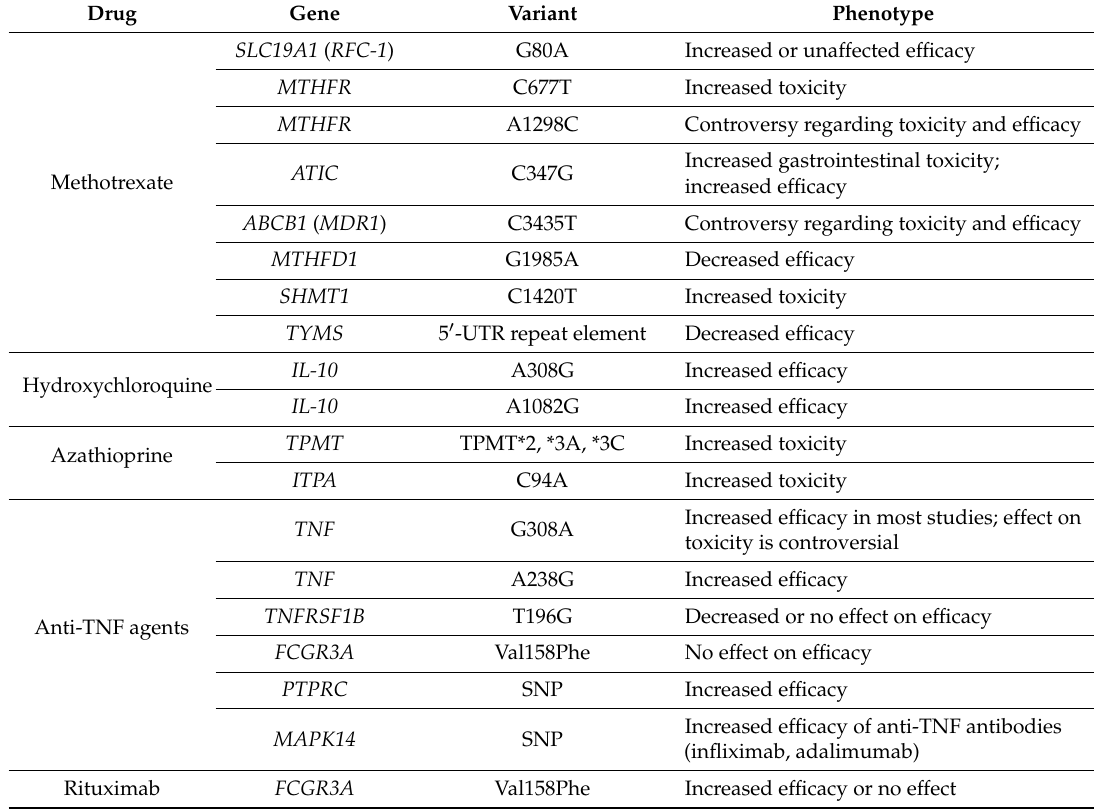
Table 4. The pharmacogenetics of